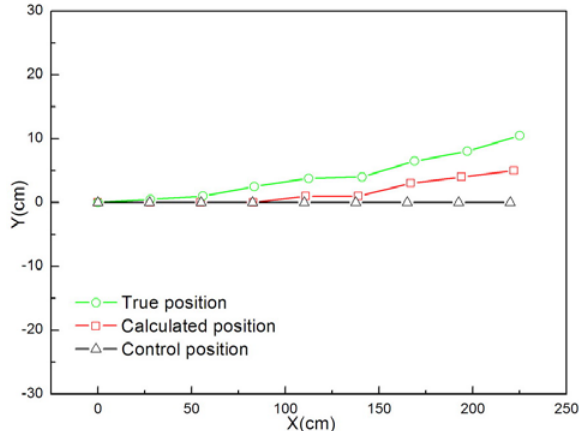
Figure 10. Cumulative errors in localization when the node is instructed to go